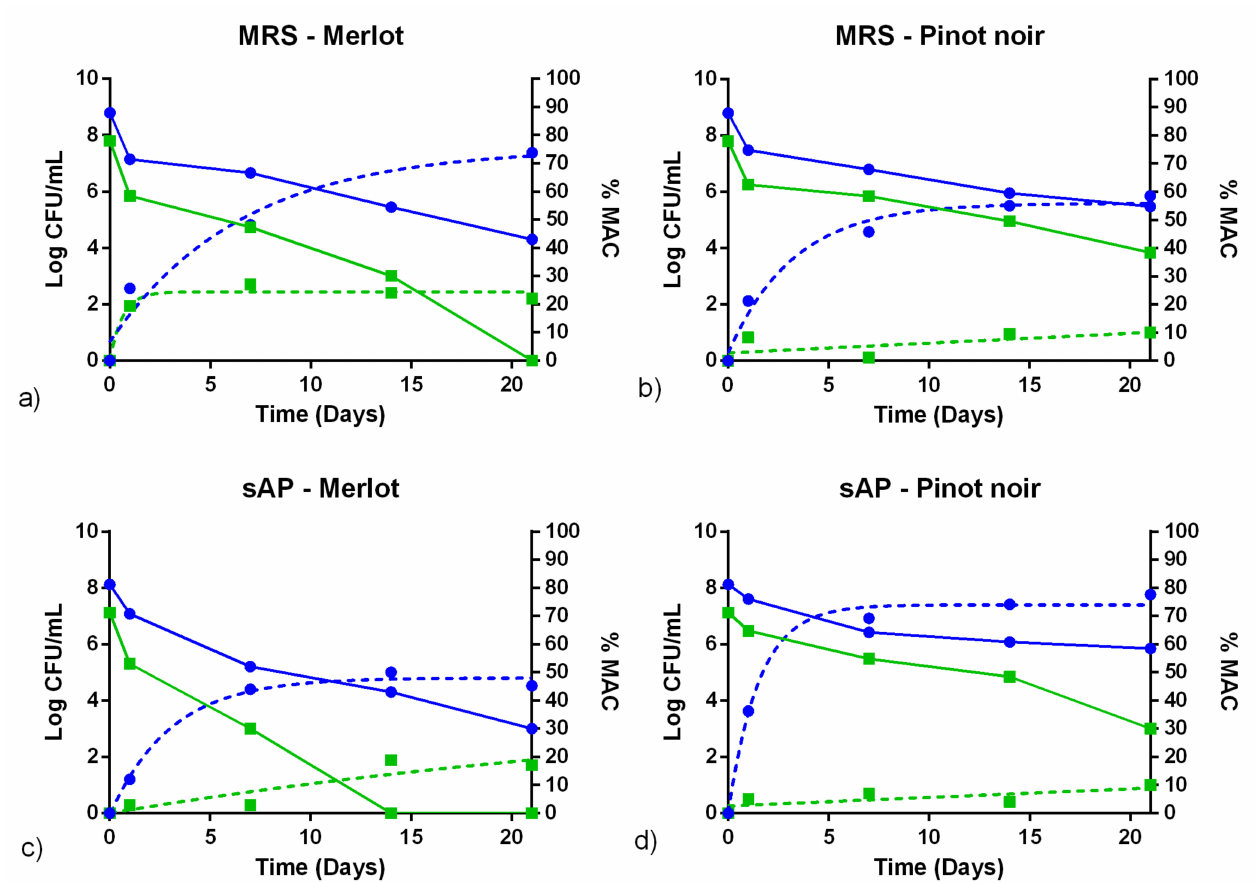
Figure 5. Fermentations in sterile Merlot wines (left column) and Pinot noir (right column) for UNQLp 155 of cultures growing in MRS pH 6.2 ( a , b ) or in sAP medium (supplemented with yeast extract, salts, and Tween) pH 6.2 ( c , d ). The full lines show the count of viables (log CFU/mL) and the dotted lines the percentage of L-malic acid consumed (% MAC ), obtained according to a non-linear regression of exponential decay. High size inoculums are displayed in blue and low inoculums in